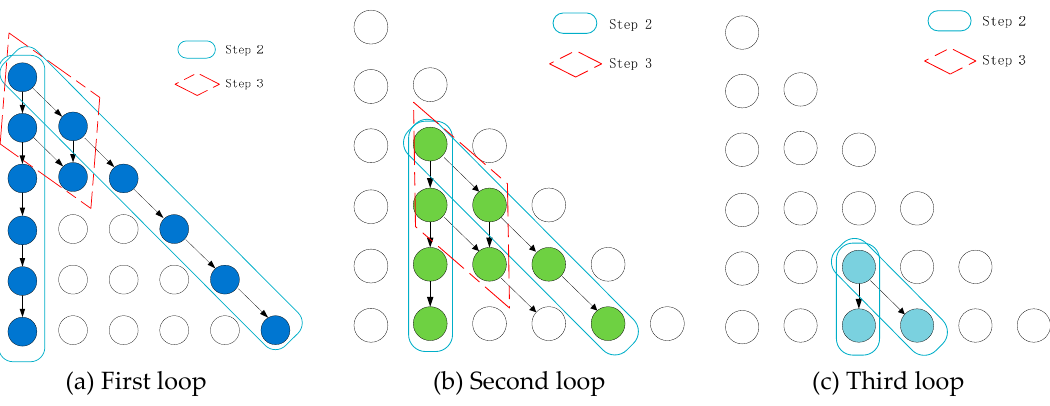
Figure 12. The steps in the proposed Matryoshka doll algorithm. Only one cycle of calculation for each part of the data is shown, and Step 1 selects the current judgment point (see algorithm). ( a ) is a schematic diagram of step 1 of the algorithm, and only the outermost dark blue nodes are involved in the calculation of this step. ( b ) is the schematic diagram of the second step and the green nodes on the second layer participate in the calculation of this step. ( c ) is similar to the previous two steps, only the light blue nodes participate in the